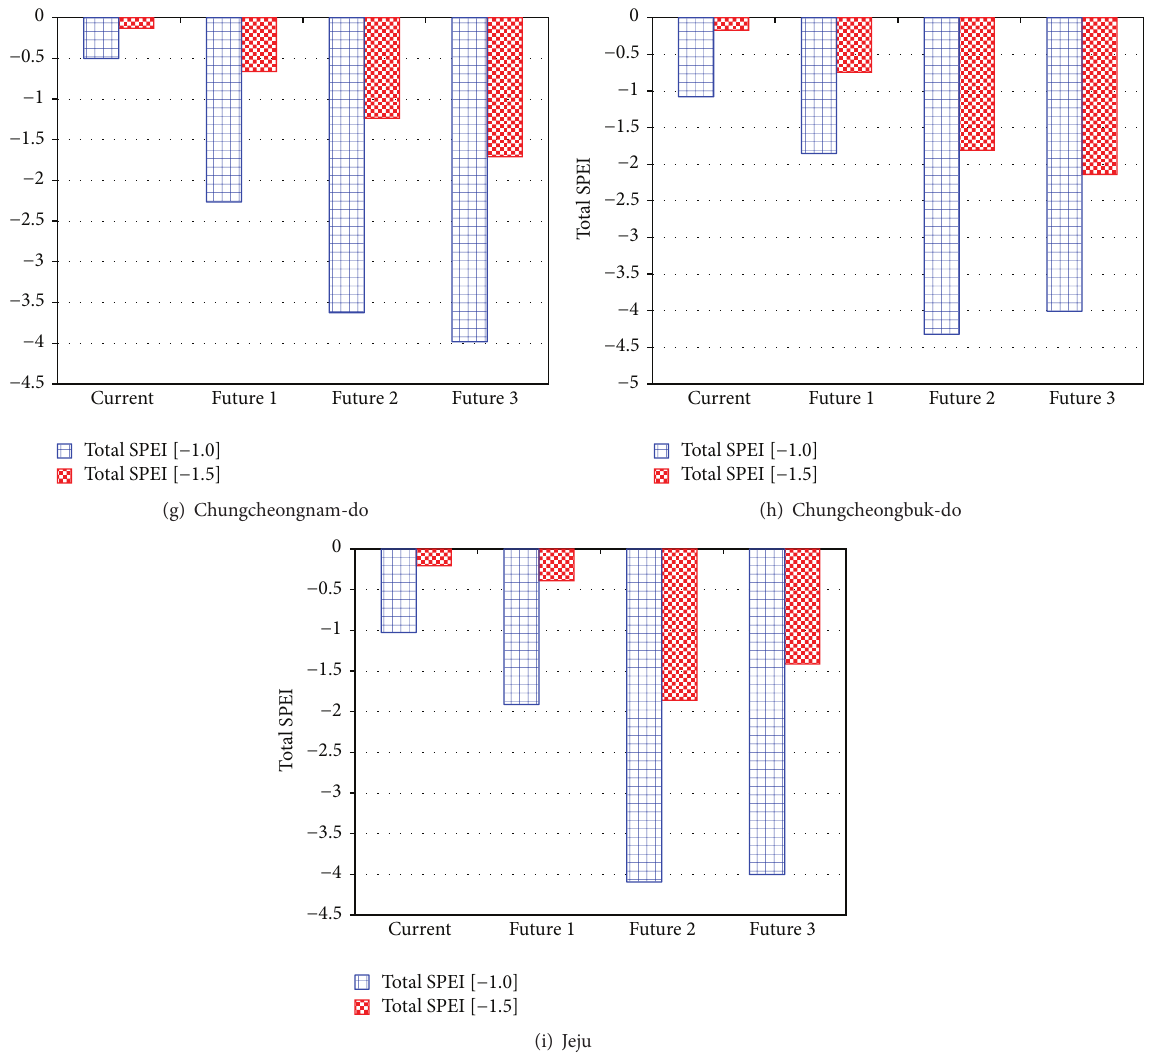
Figure 10: Change in total drought in the current and future